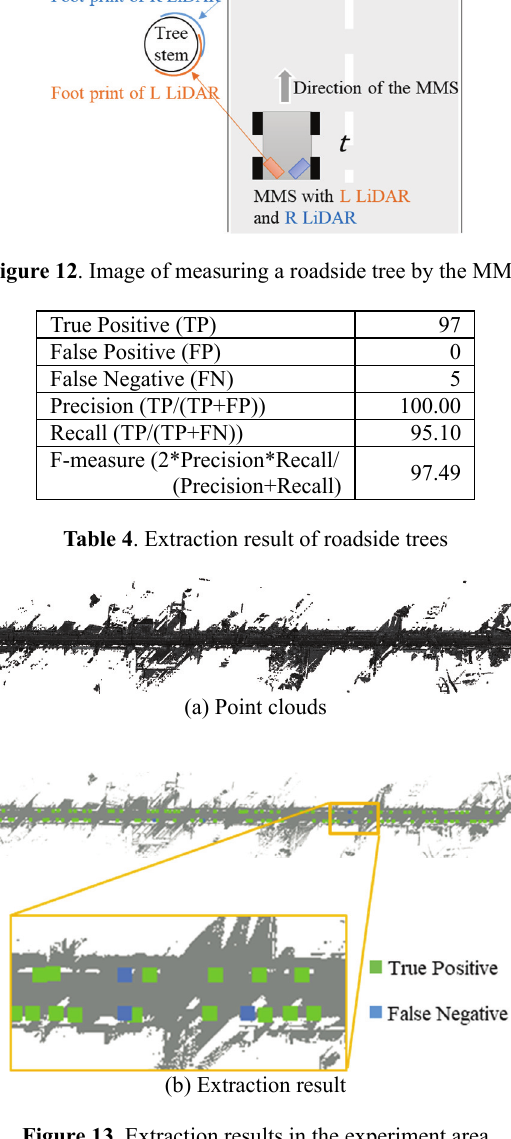
Figure 13 . Extraction results in the experiment